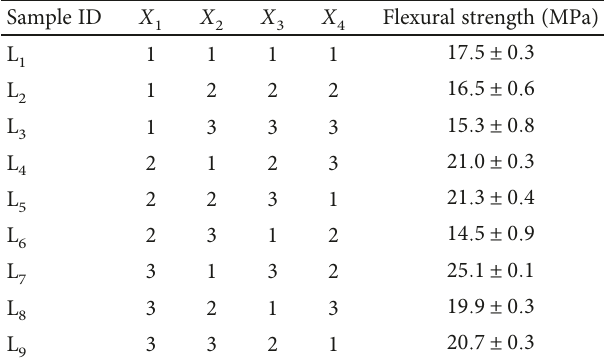
Table 3: Schemes and results of the orthogonal experiment.